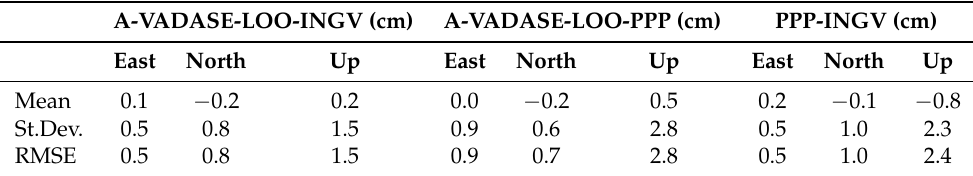
Table 8. Differences of coseismic displacements: 24 August 2016 earthquake.